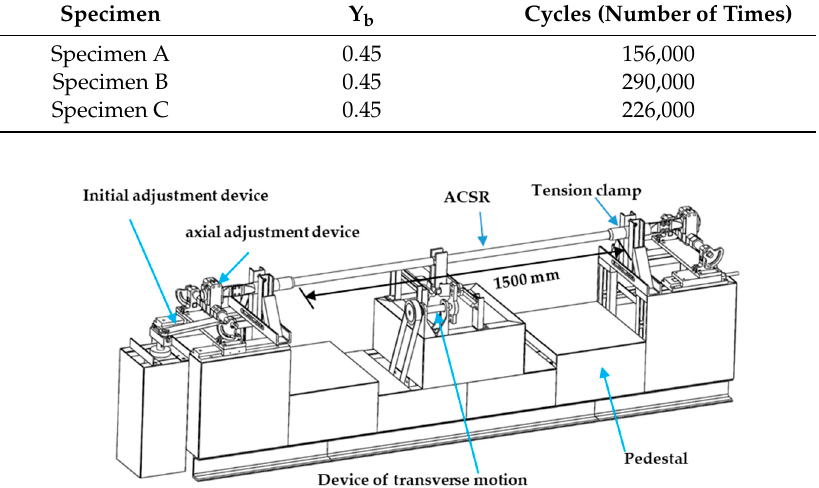
Table 3. Results of fatigue tests.